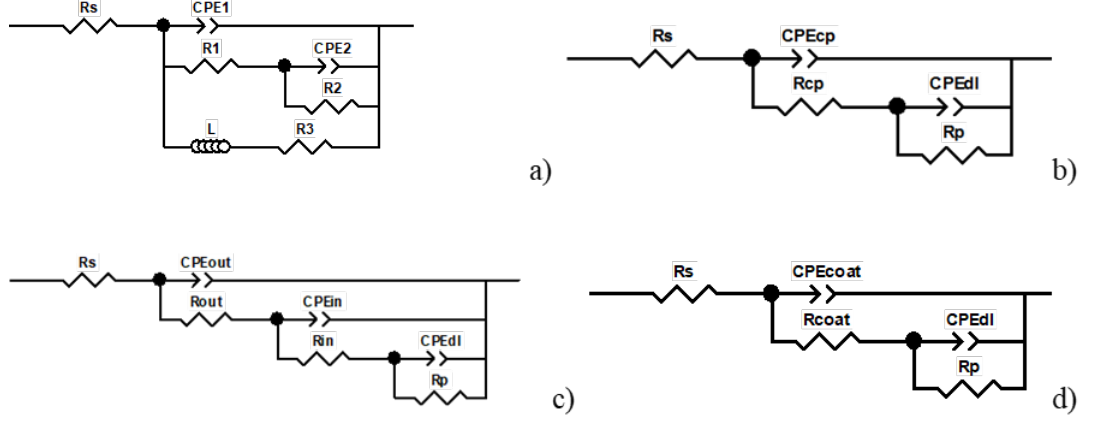
Figure 9. Equivalent electrical circuits used for fitting the EIS spectra of the AZ31B substrate and the Bonderite CC ( a , b ) and of the FPEO coatings ( c , d ) after 30 min ( a , c ) and 24 h ( b , d ) of immersion in 0.5 wt.% NaCl.